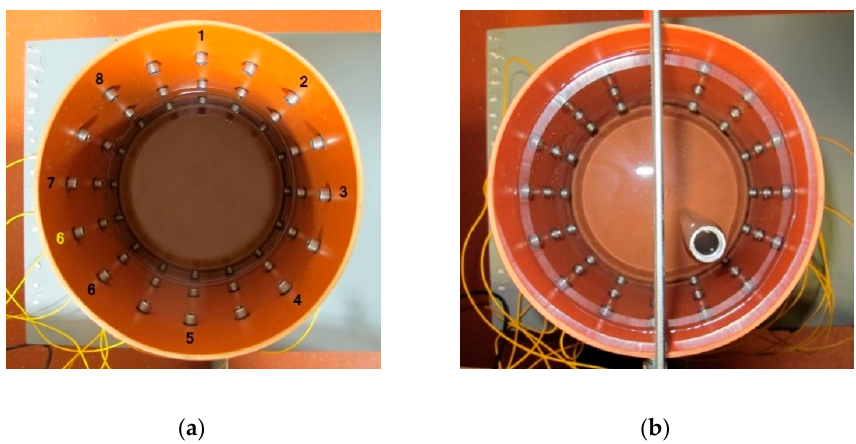
Figure 11. The experimental setup to induce electrode misplacement: ( a ) the shifted 6th electrode; ( b ) the tomograph (19 × 19 cm 2 ) filled with water and containing an aluminum object.